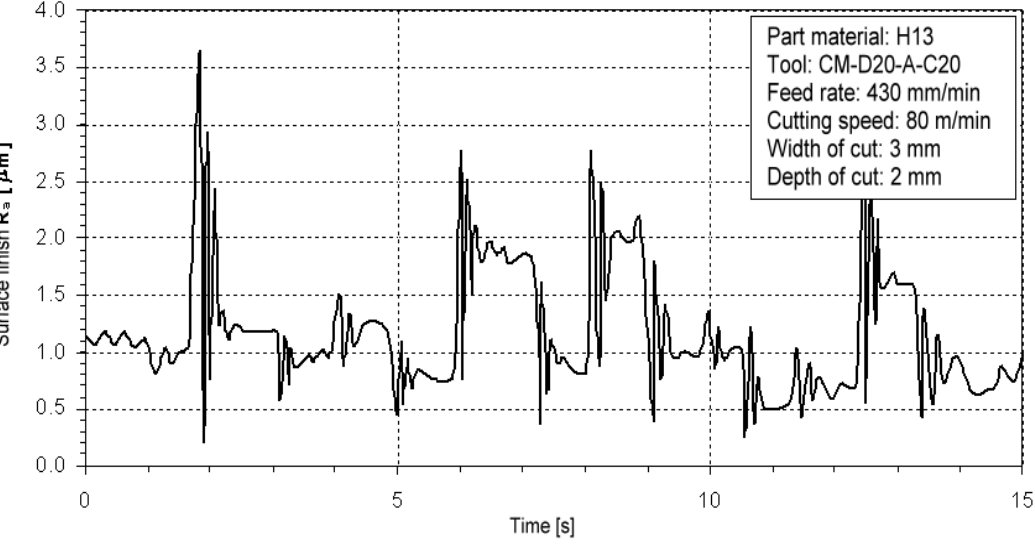
Figure 5. “R a before the simulation”. Source: